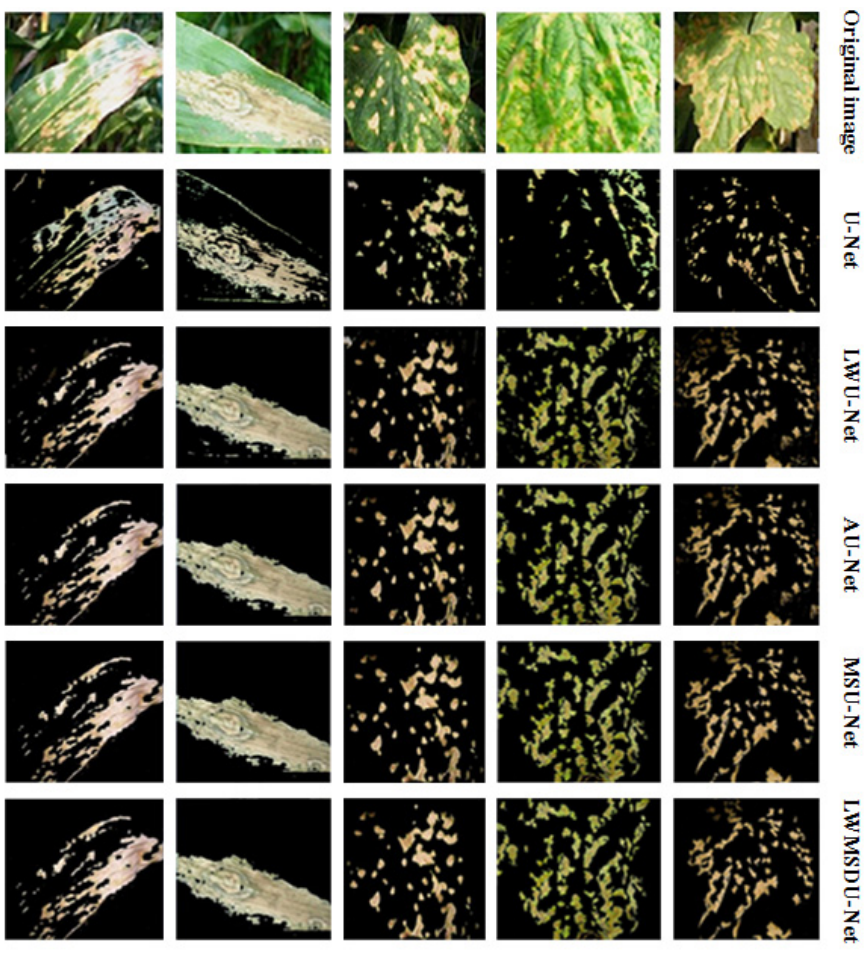
Figure 10. Typical segmented disease leaf images by 5 models.